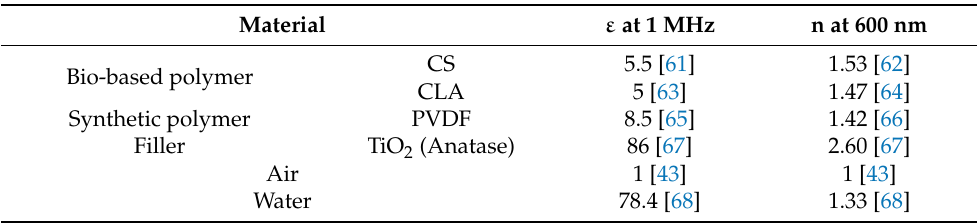
Table 2. Dielectric constants and refractive indexes of polymers matrixes, TiO 2 NPs filler, water, and air at room temperature (298.15